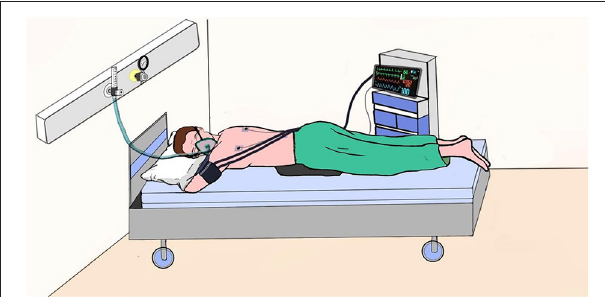
FIGURE 1 | Cartoon demonstrating continuous prone positioning with oxygen supplementation only via Venturi Mask demonstrated under continuous